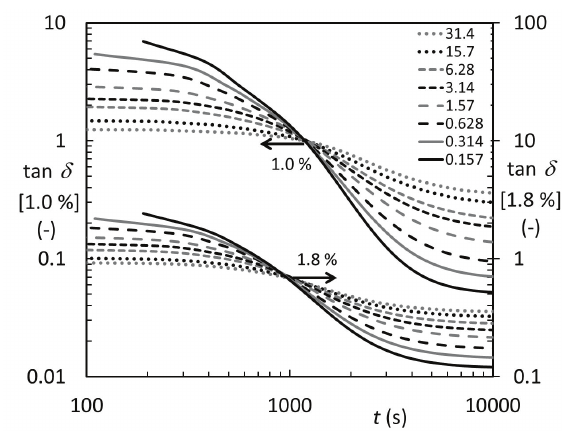
Fig. 6 – Time evolution of the loss tangent at eight different frequencies (from 0.157 rad s –1 to 31.4 rad s –1 ) for system 1.0 %wt and 1.8 %wt